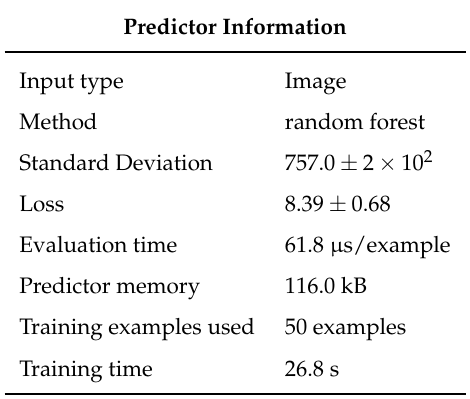
Table 1. Parameters of the random forest